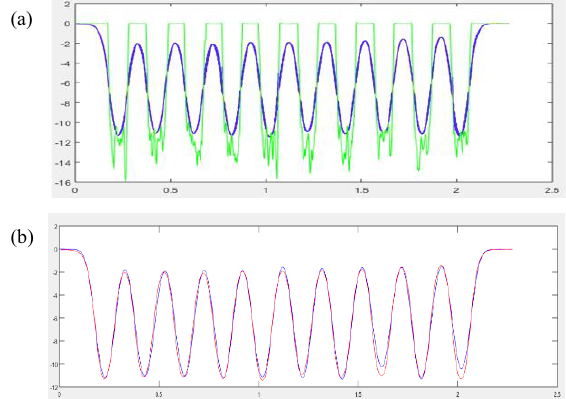
Fig. 2. (a) Cross section of laser machined rectangular line structures (green) and plasma jet smoothed profile (blue), (b) Comparison of plasma smoothed profile (blue) and filtered original profile using the calculated Gaussian filter function.